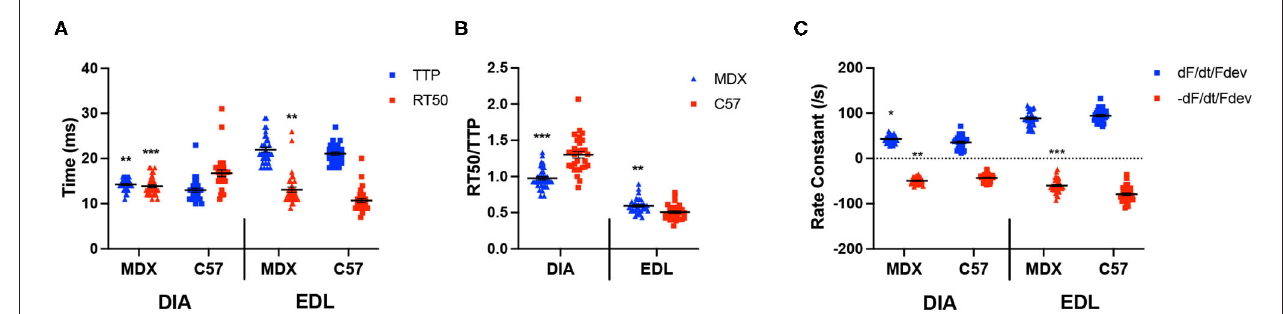
FIGURE 3 | (A) Time to peak and 50% relaxation of 52 week old dystrophic and wildtype muscle types. Kinetic analysis was conducted in diaphragm and EDL muscles from the same mice. Mouse models include dystrophic MDX and wildtype C57BL/10. Statistical analysis was conducted using a two-sided t -test. ** P < 0.01 and *** P < 0.001 compared to C57BL/10 mice. The line represents the group mean; error bars are standard error of mean. (B) 50% relaxation of 52 week old dystrophic and wildtype muscle types. Mouse models include dystrophic MDX and wildtype C57BL/10. Statistical analysis was conducted using a two-sided t -test. ** P < 0.01 and *** P < 0.001 compared to C57BL/10 mice. The line represents the group mean; error bars are standard error of mean. (C) Rate constants of individual diaphragm and EDL twitches. Mouse models include dystrophic MDX and wildtype C57BL/10. Statistical analysis was conducted using a two-sided t -test. * P < 0.05, ** P < 0.01, and *** P < 0.001 compared to C57BL/10 mice. The line represents the group mean; error bars are standard error of